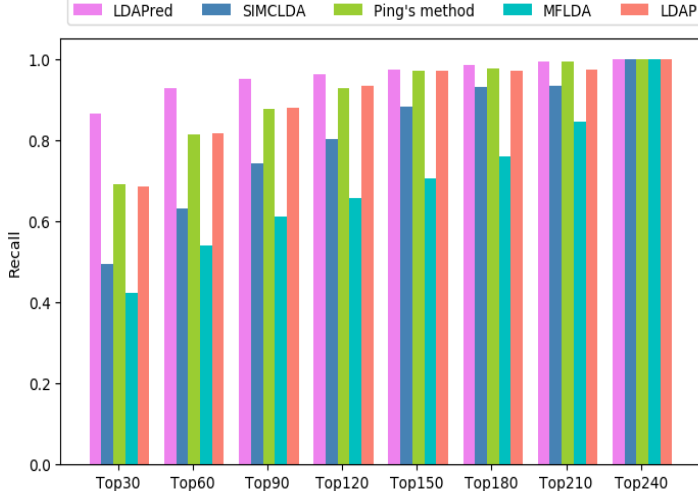
Figure 2. Recall values of the top k candidates of LDAPred and the other four methods.